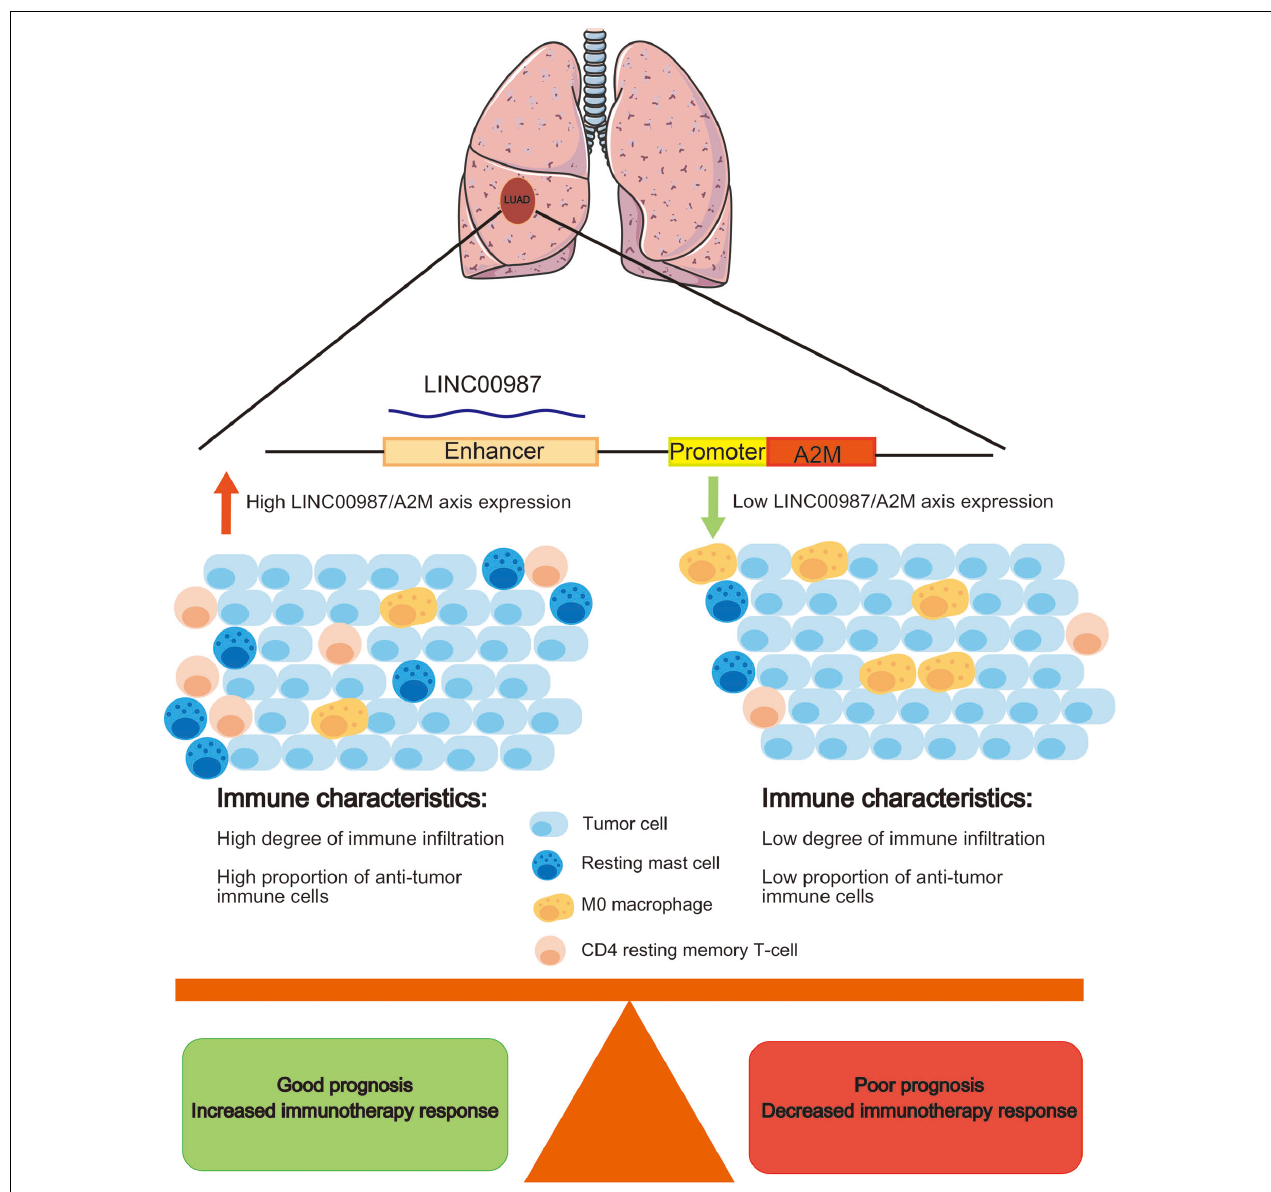
FIGURE 12 | Schematic diagram. LUAD patients with a high LINC00987/A2M axis expression have a better prognosis, with an increased proportion of antitumor immune cell infiltration. Immunotherapy may improve the prognosis of LUAD patients with a high LINC00987/A2M axis